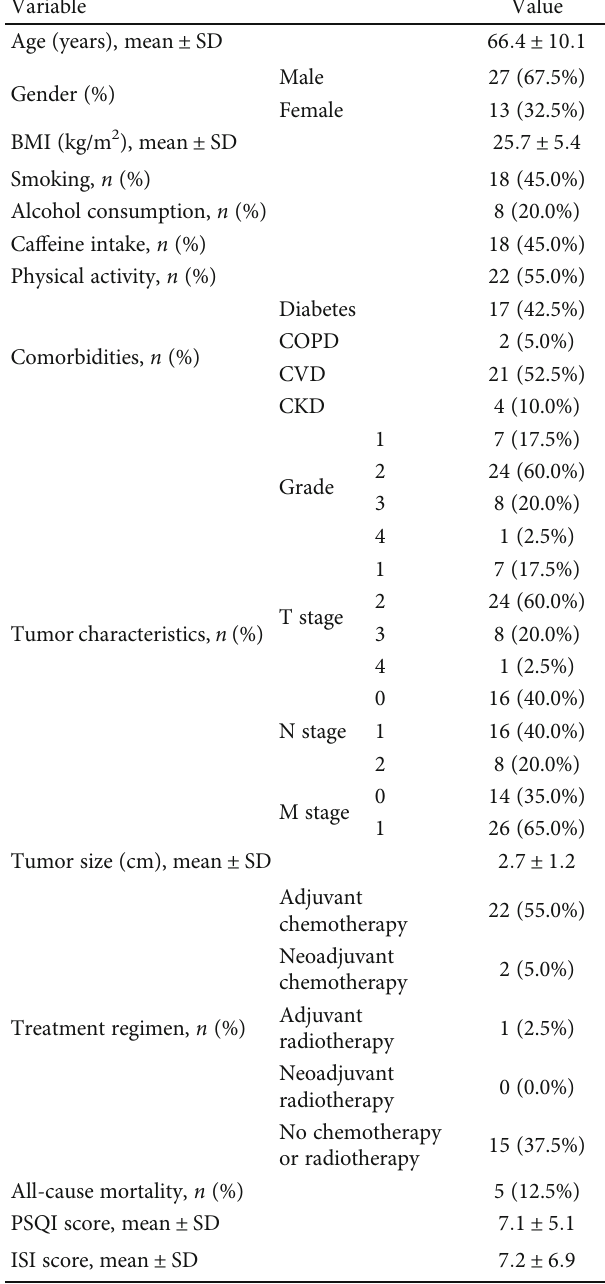
Table 1: Patient